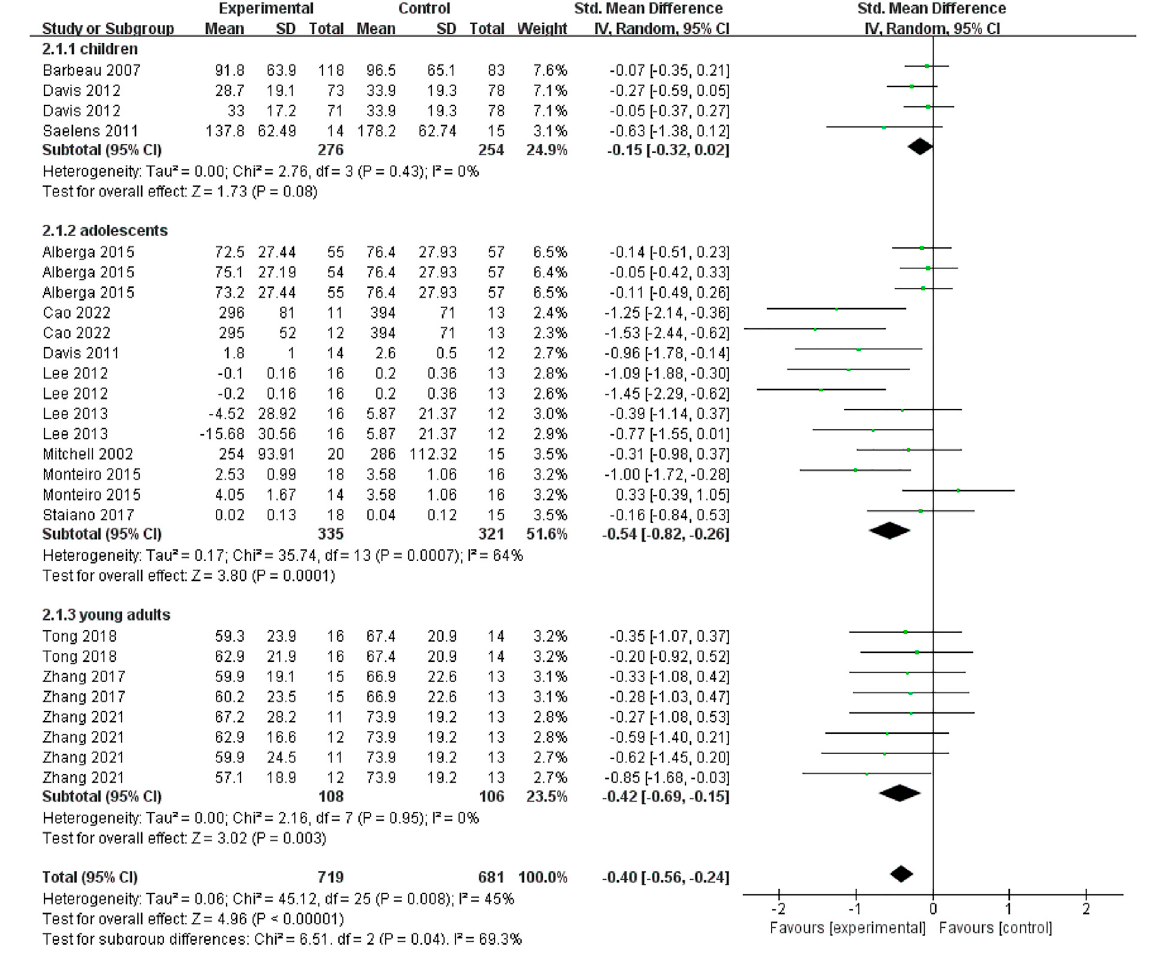
FIGURE 4 Subgroup analysis of age related to the effect of exercise interventions on visceral fat in young individuals with obesity or overweight.